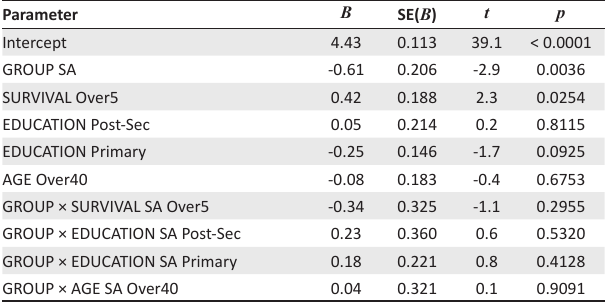
TABLE 9: Parameter estimates for two-way interaction analysis of variance model of competitor-driven